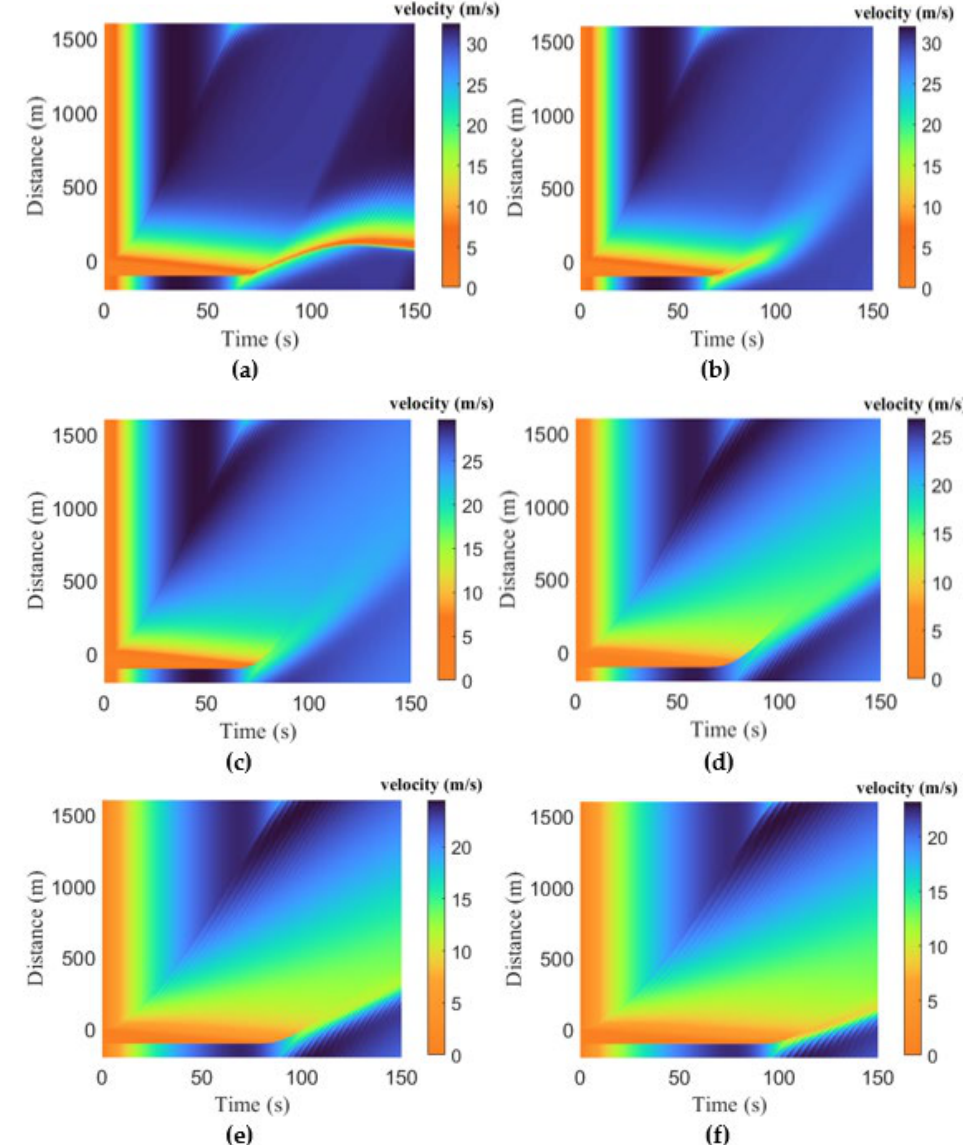
Figure 7. Velocity evolution over time and space for the proposed model on an 1800 m circular road: